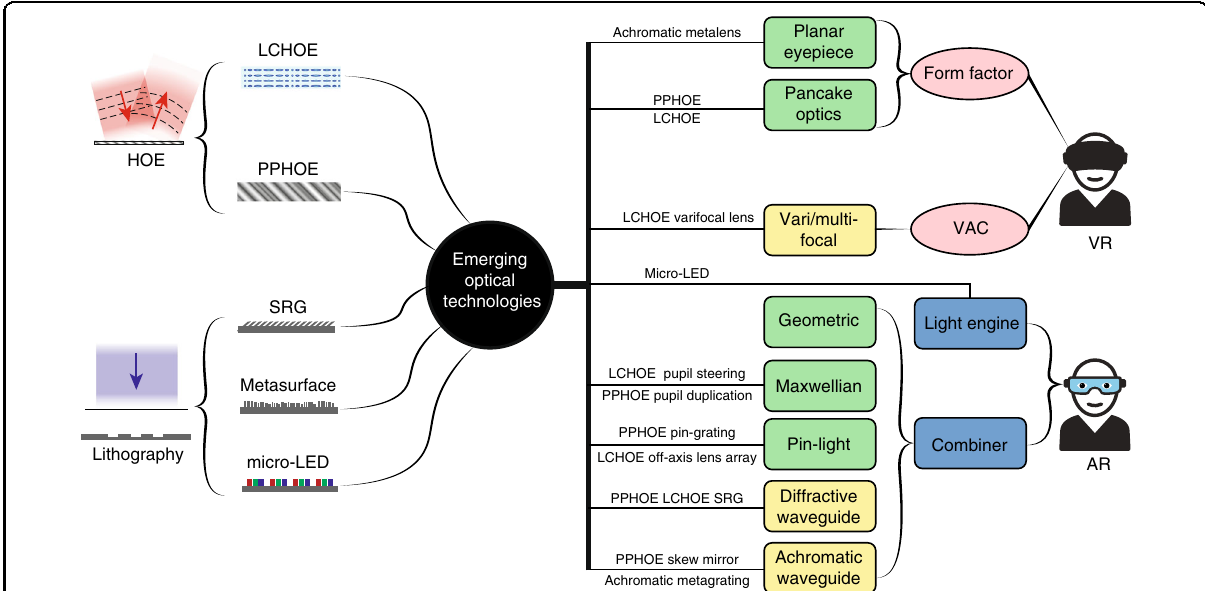
Fig. 1 Schematic of some emerging optical technologies applied in AR/VR. The left side illustrates HOEs and lithography-based devices. The right side shows the challenges in VR and architectures in AR, and how the emerging technologies can be applied